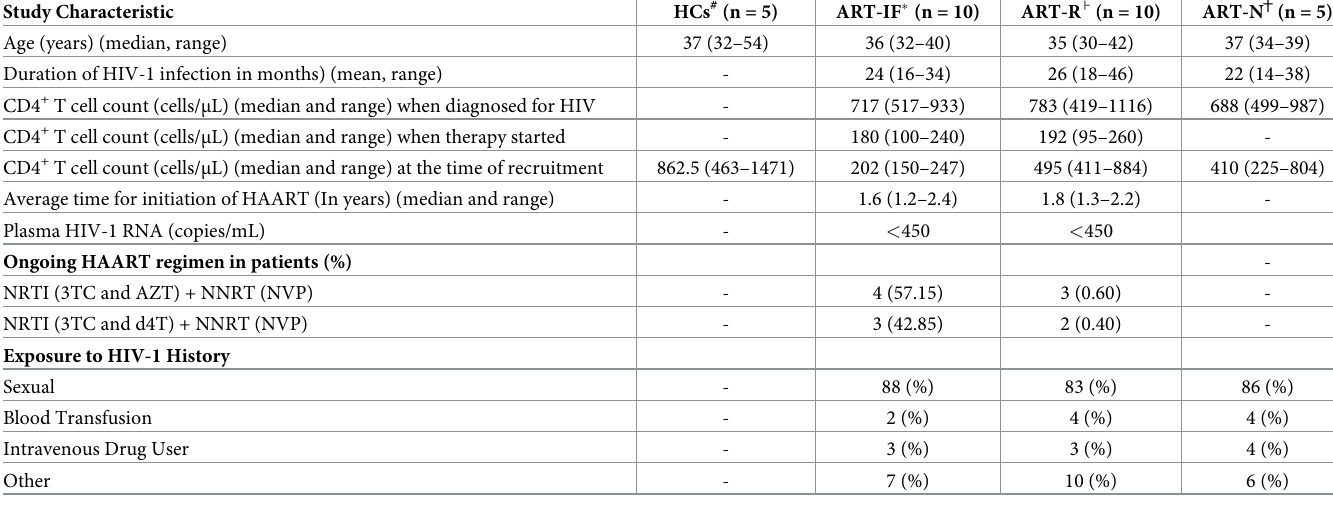
NRTI (Nucleoside reverse transcriptase inhibitors) 3TC (Lamivudine), AZT (Zidovudine), d4T